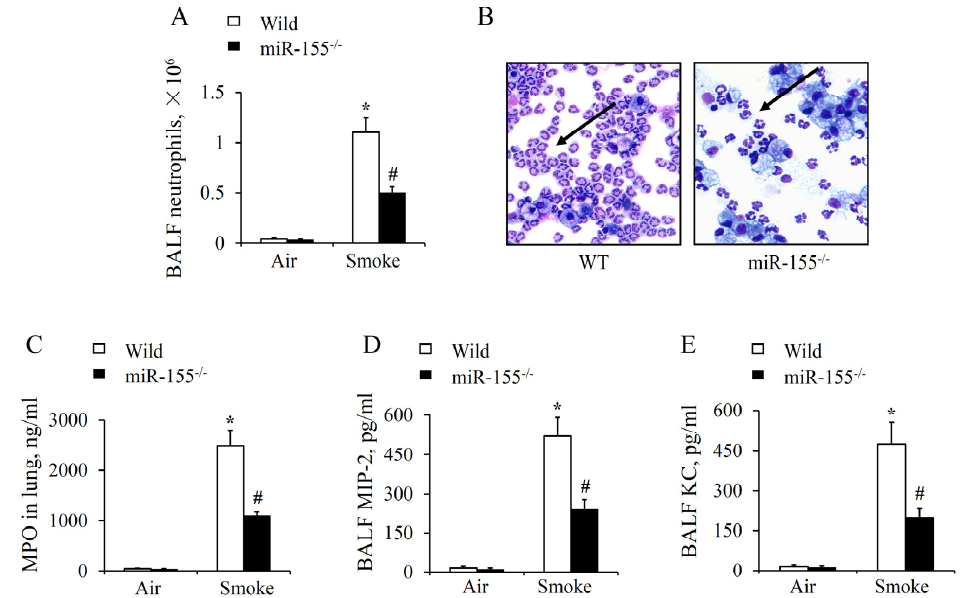
Figure 3. MiR-155 absence attenuated neutrophil activation and accumulation. Bronchoalveolar lavage fluid (BALF) and lung tissue were harvested at 12 h after 15 min of smoke exposure. ( A ) Cell counts of BALF neutrophils was determined. ( B ) Diff-Quick-stained cytospins of bronchoalveolar lavage neutrophils after smoke inhalation, original magnification 400×. ( C–E ) The myeloperoxidase (MPO) level in lung tissue and macrophage inflammatory protein 2 (MIP-2) and keratinocyte chemoattractant (KC) proteins in BALF were measured by ELISA. n = 4 mice per group. * p < 0.05 vs. WT mice treated with air. # p < 0.05 vs. WT mice treated with smoke.